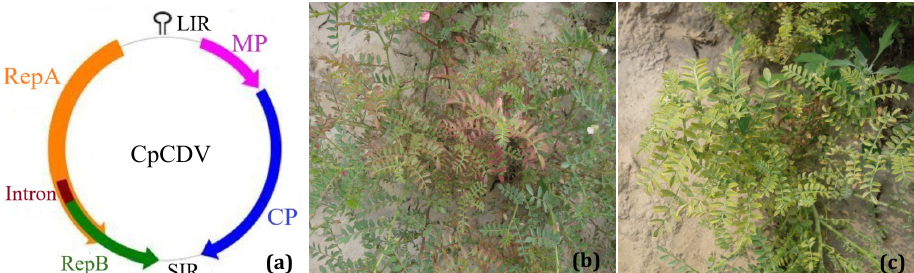
Figure 1. ( a ) Schematic diagram of the CpCDV genome representing virion and complementary open reading frames, Movement protein (MP), Capsid protein (CP), and Replication associated protein A and B (RepA and RepB), LIR and SIR—large and small intergenic regions. Intron and stemloop region are indicated. Chickpea plants showing ( b ) leaf reddening and ( c ) leaf smalling; stunting and proliferation of axillary